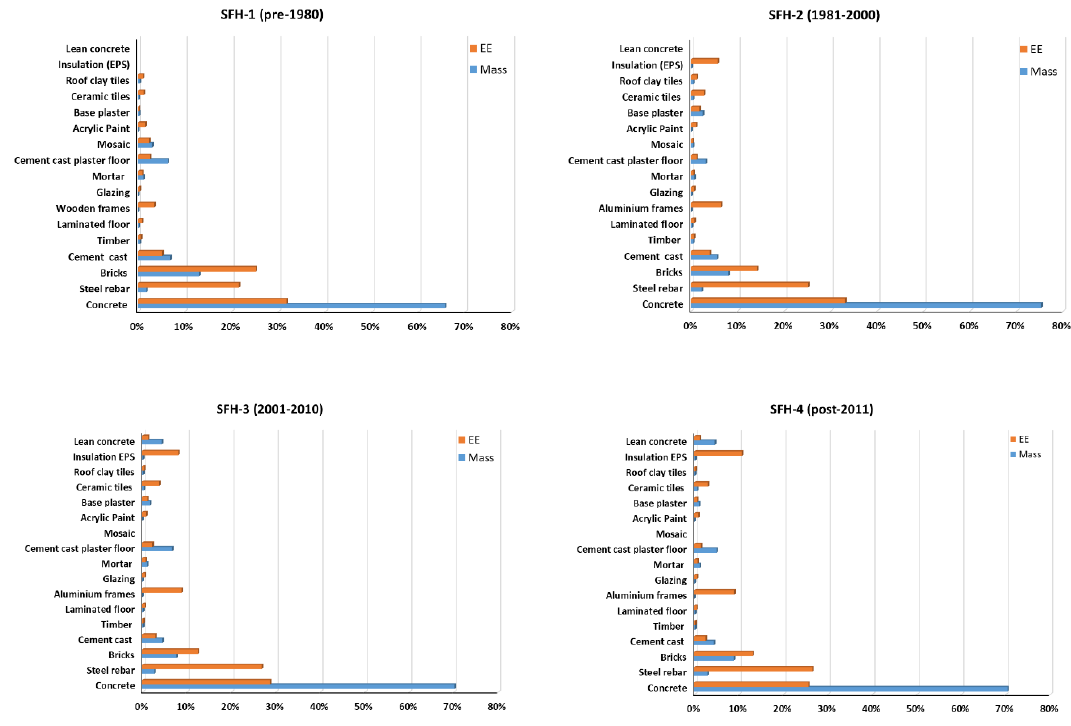
Figure 3. Percentage of the total building mass and embodied energy for the materials used in the case studies and averaged for the four construction